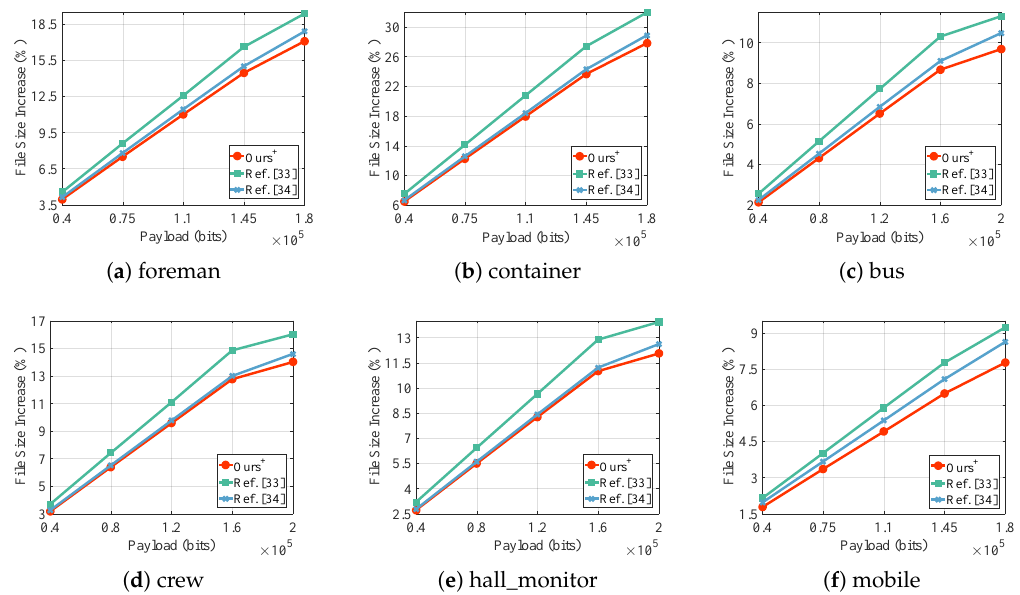
Figure 7. The increase in the file size of marked video generated by different schemes using the ( 0,0 ) coefficient pairs when QP is 16.